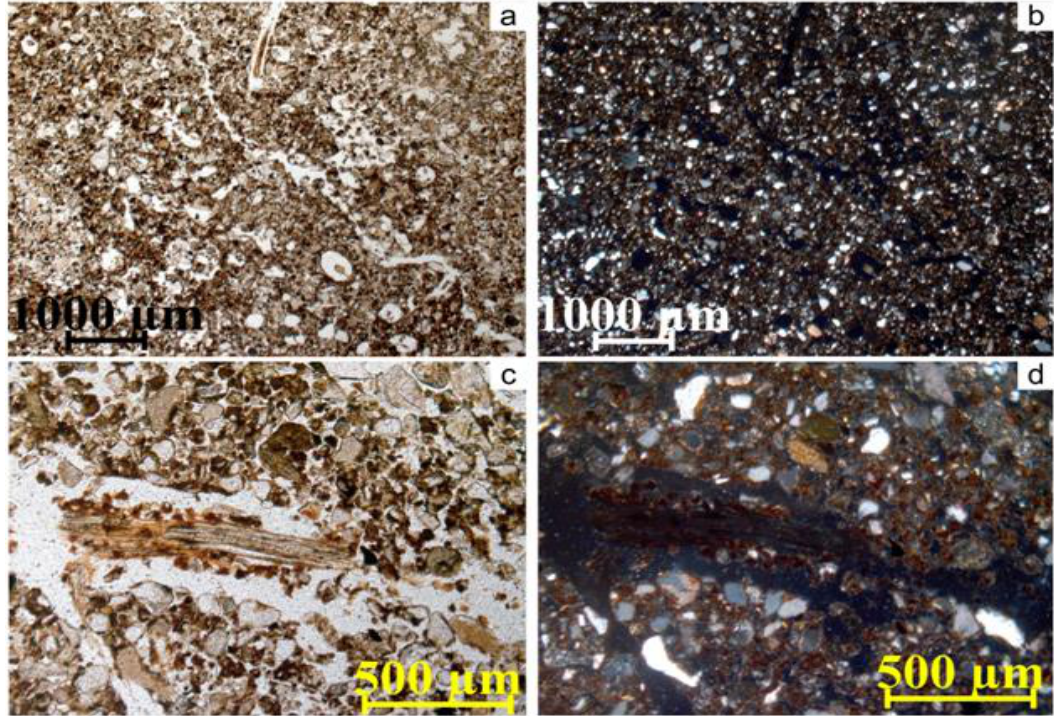
Figure 3. Micromorphological features of the humus horizon of modern reference soil at the depth 10–20 cm: а , b —weakly separated granular microstructure, complex packing voids, small granules with great content of organic fine material, tissue residues, and signs of mezofauna activity in voids ( a —PPL; b —XPL); c , d —tissue residue with visible cell structure surrounded by brown and black